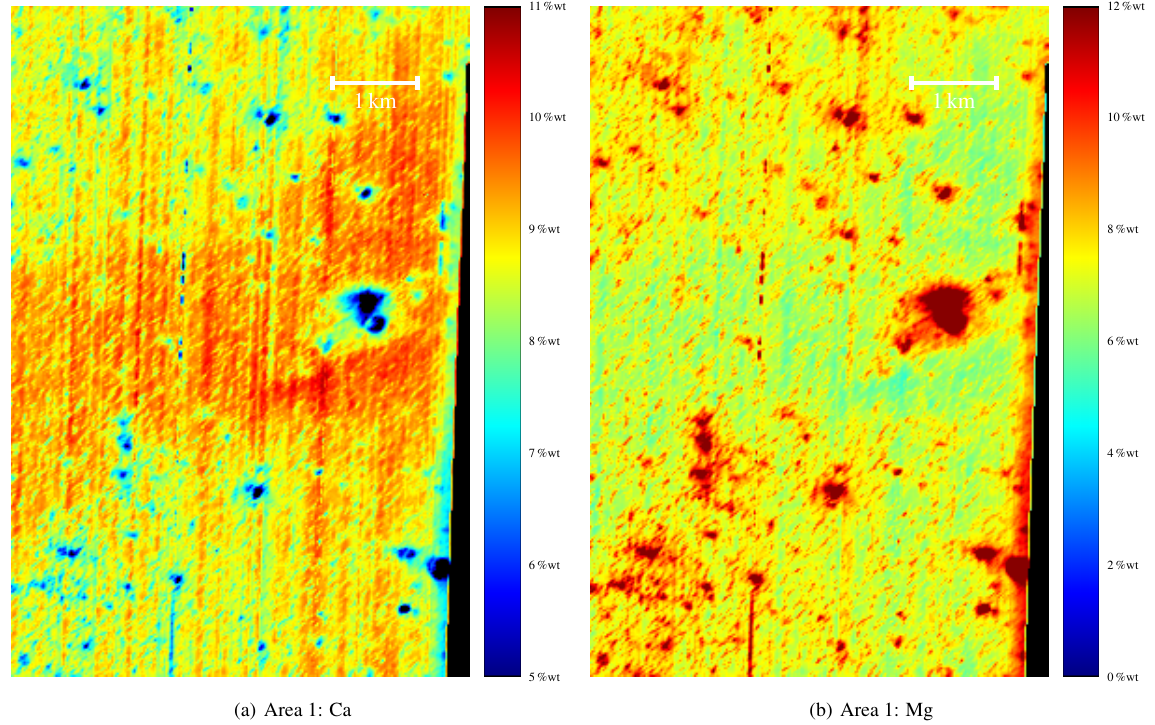
Figure 6: Elemental abundance maps of Area 1. The lava flow shows (a) an enrichment in Ca and (b) a depletion in Mg. Black denotes missing